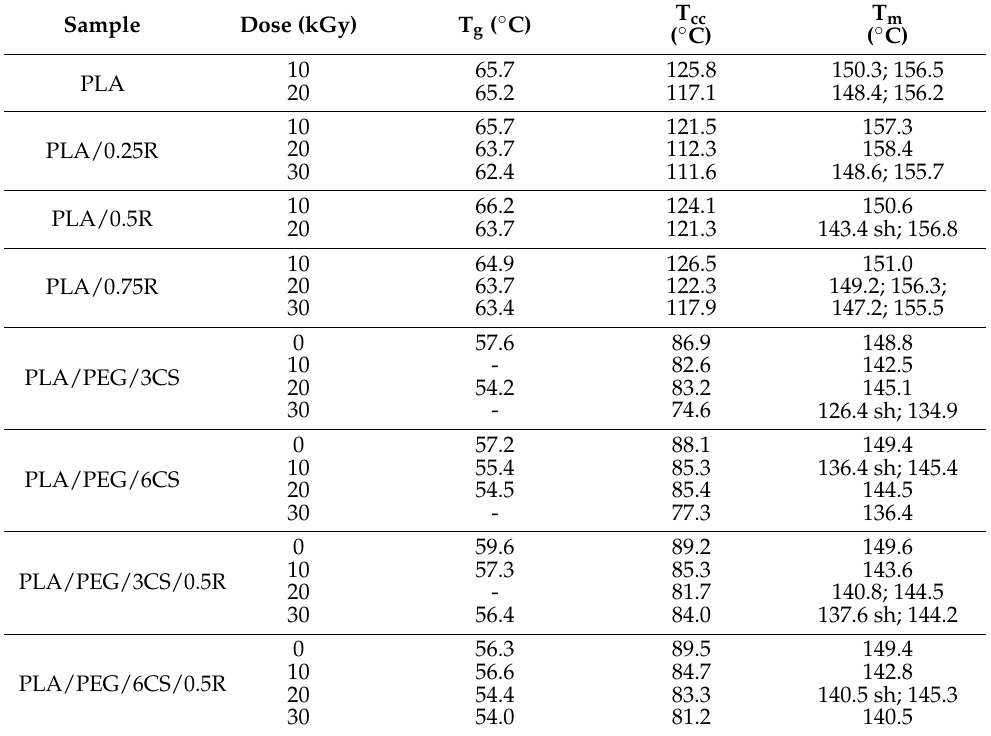
Table 2. Thermal characteristics determined from DSC curves recorded in the 2nd heating run for the non-irradiated and irradiated PLA/R blends and PLA/PEG/CS/R biocomposites.